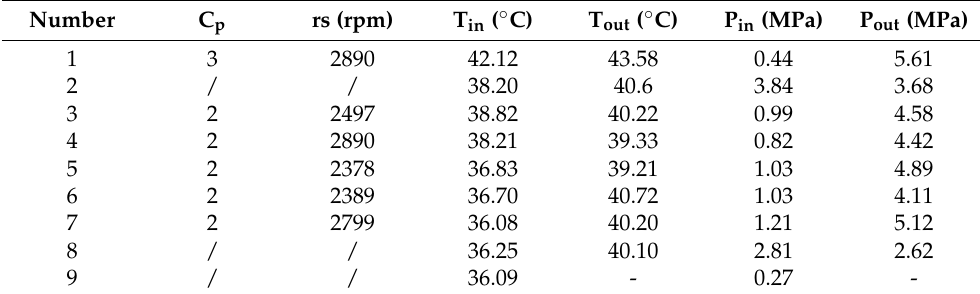
Table A4. DE simulation operation